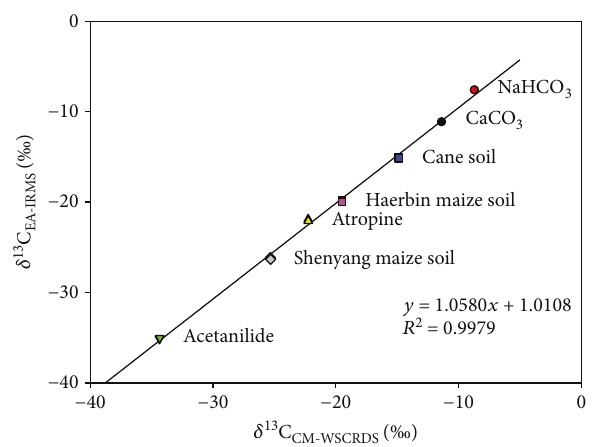
Figure 4: Correlation of δ 13 C values measured by CM-CRDS ( n = 5 ) and comparison system.